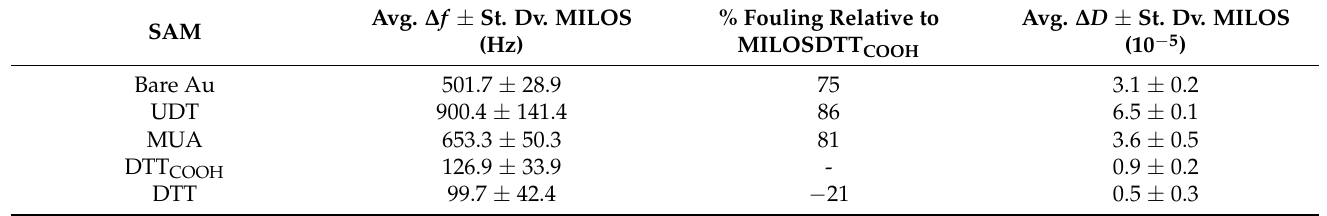
Table 1. Frequency and dissipation shift after exposure to undiluted human serum and subsequent wash with PBS.